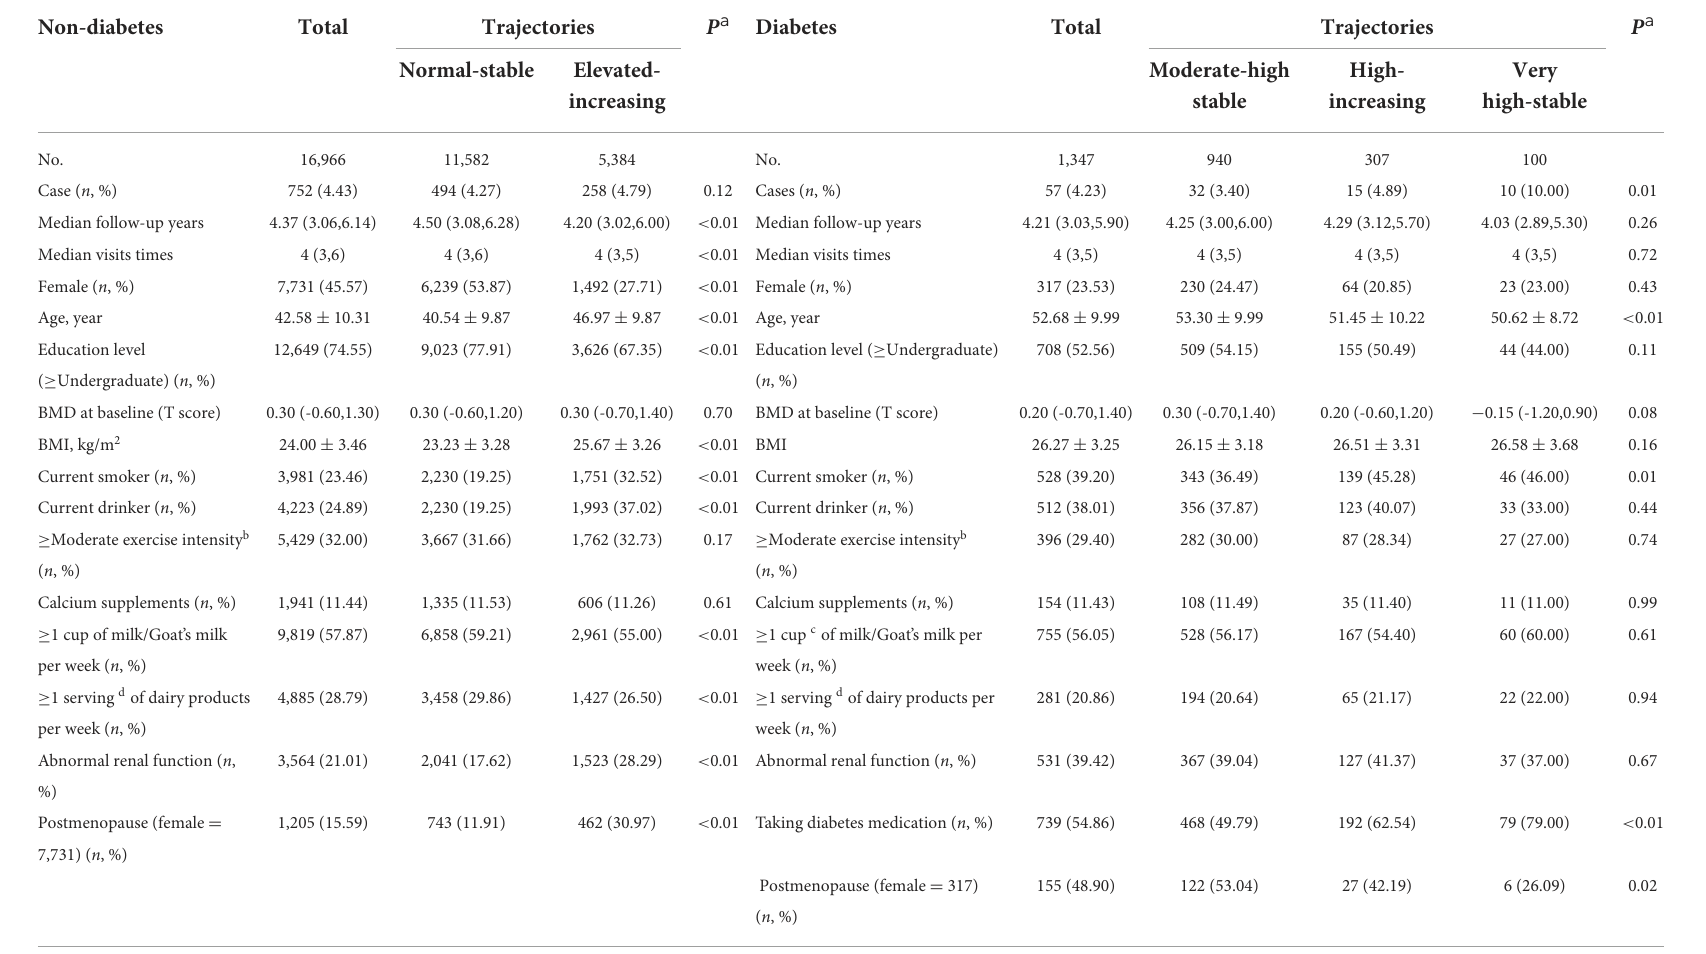
TABLE 1 Baseline characteristics in non-diabetic and diabetic participants a . Non-diabetes Total Trajectories P a Diabetes Total Trajectories P a